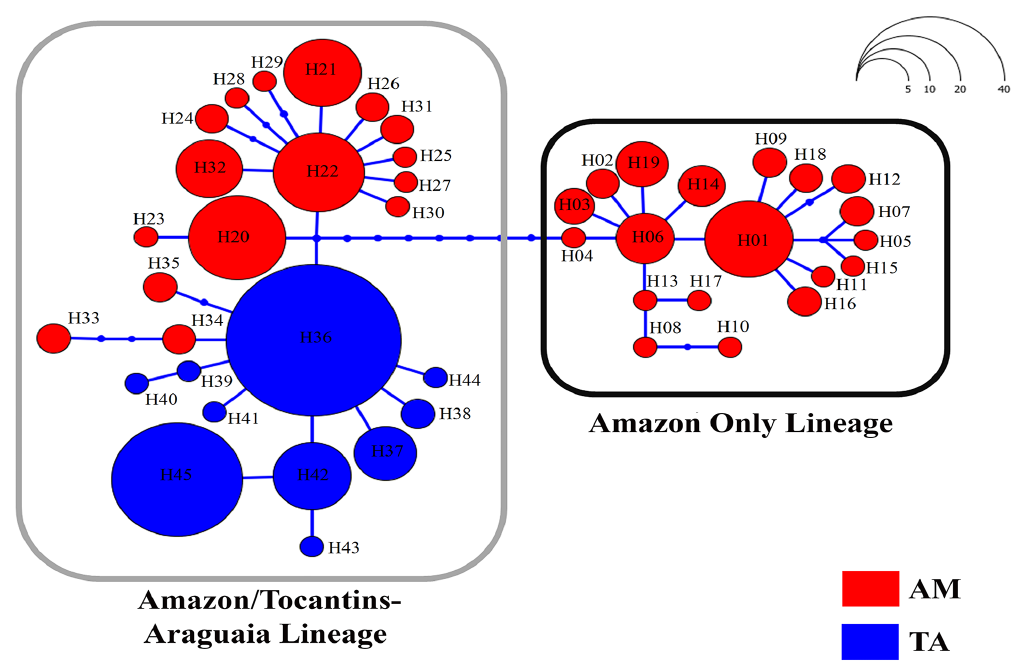
Figure 2. Genetic relationships among the Arapaima haplotypes. Haplotype network produced by the Maximum Likelihood method, based on the concatenated Cytb and Control Region data set. The Amazon populations are represented by red circles, and the Tocantins-Araguaia populations, by blue circles. The Amazon Only Lineage is outlined in black, and the Amazon/Tocantins-Araguaia Lineage, in